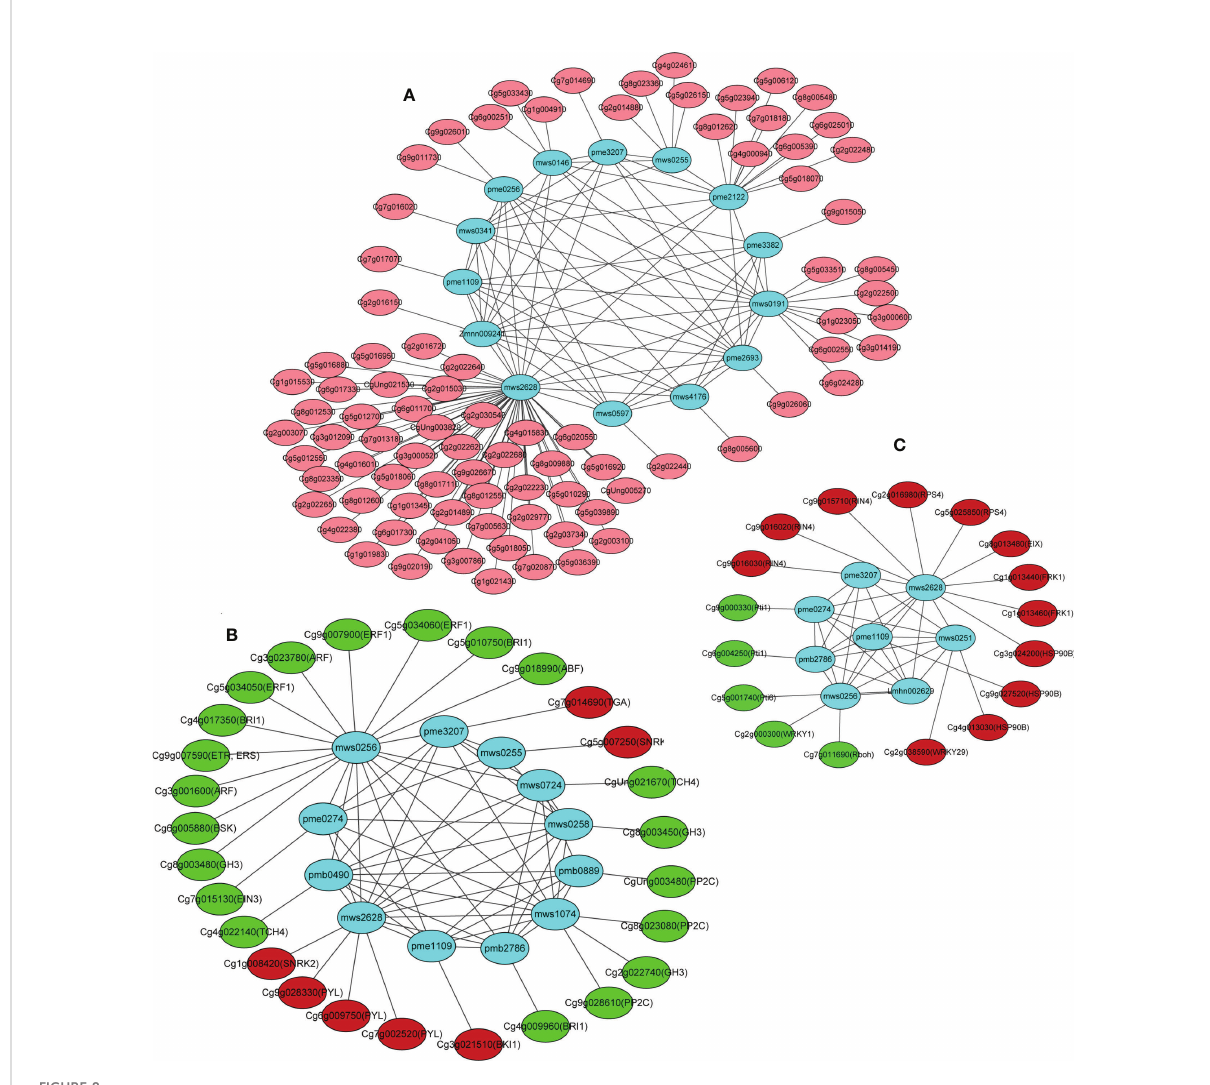
FIGURE 8 Pearson ’ s correlation network model diagram of the DEGs and DAMs. (A) Cluster I network represents differentially expressed genes and metabolites associated with fl owers. (B) Cluster II network represents plant hormone signal transduction pathway related DEGs and DAMs. (C) Cluster III network represents plant pathogen resistance-related DEGs and DAMs. Each blue node (circle) represents a metabolite. Signi fi cant metabolite – metabolite and gene – metabolite connections are represented by the edges (lines). A network graph was constructed using the correlation data for the CON and OEGA metabolites. Nodes without connections to other nodes were deleted. Red (or pink) and green colors represent up- or downregulation in the CON vs. OEGA groups,